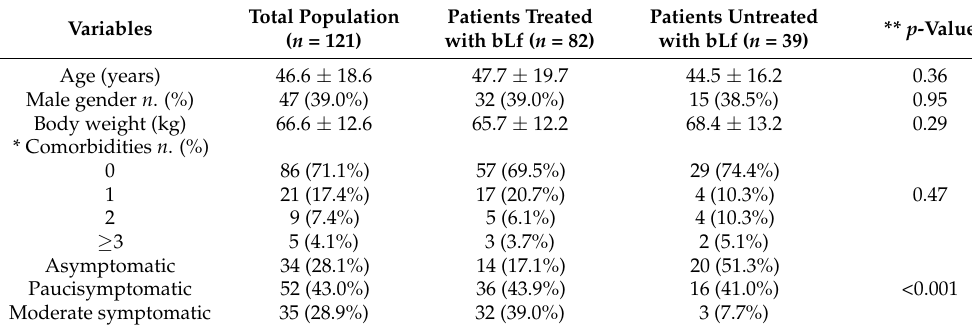
Table 1. Main characteristics of